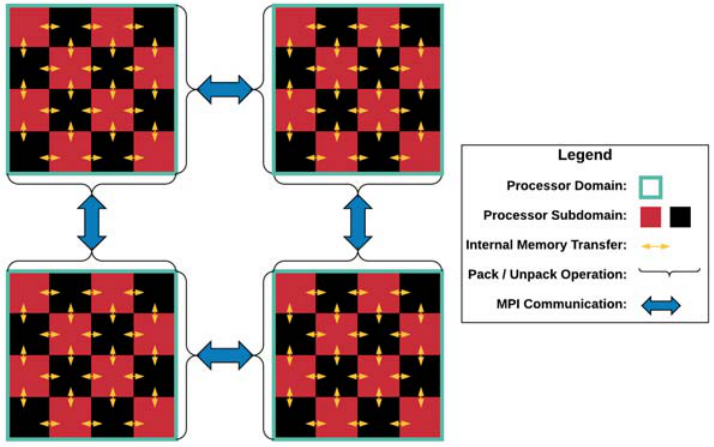
Figure 1: 2D Analogue of PIDOTS Decomposition for RB-4, p